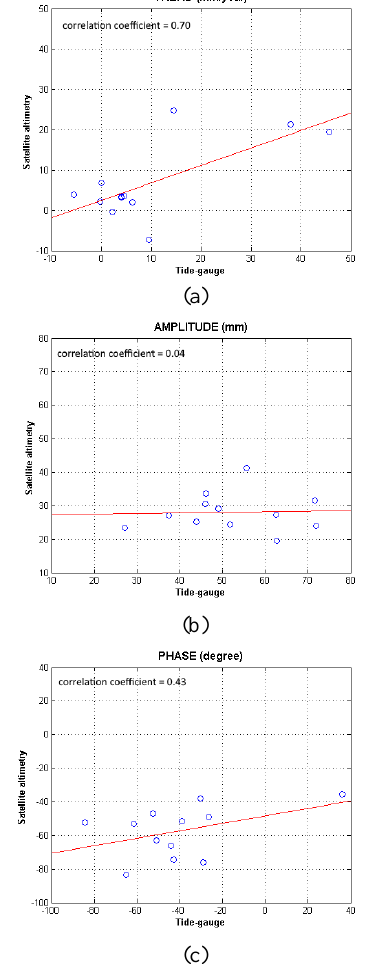
Figure 3. Correlation coefficients between satellite altimetry and tide gauge results for (a) trend, (b) amplitude, and (c)